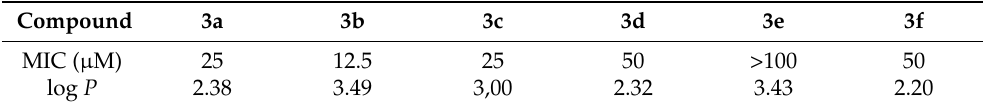
Table 2. MIC and log P values of benzo[ a ]phenoxazinium chlorides 3a–f against the yeast S.